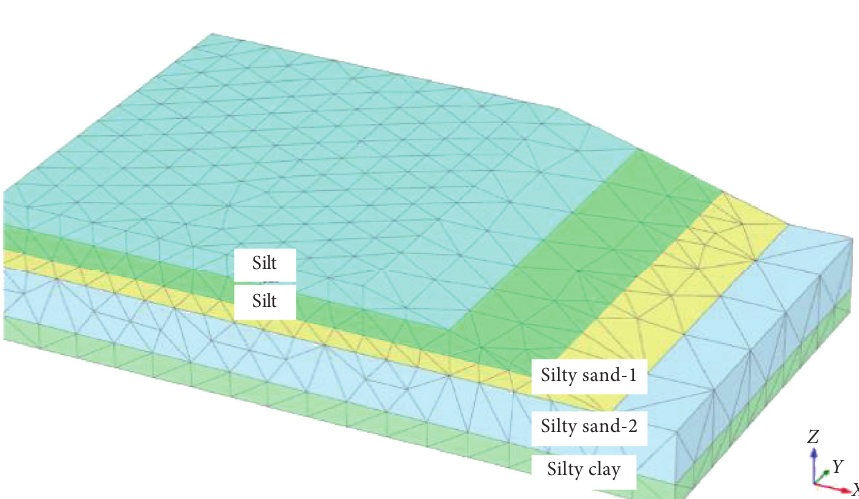
Figure 6: The three-dimensional mesh of Wildlife Site